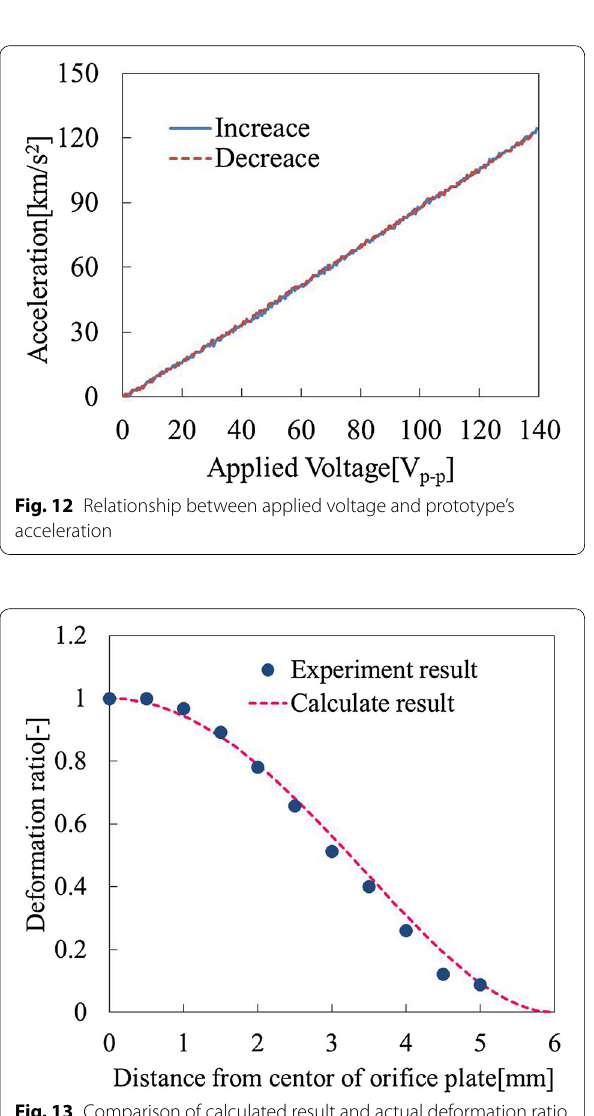
Fig. 13 Comparison of calculated result and actual deformation ratio value